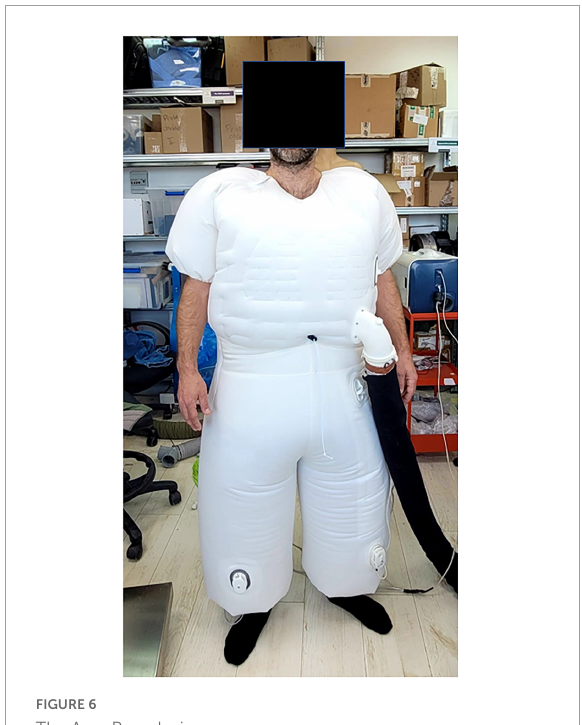
FIGURE6 The AquaPass